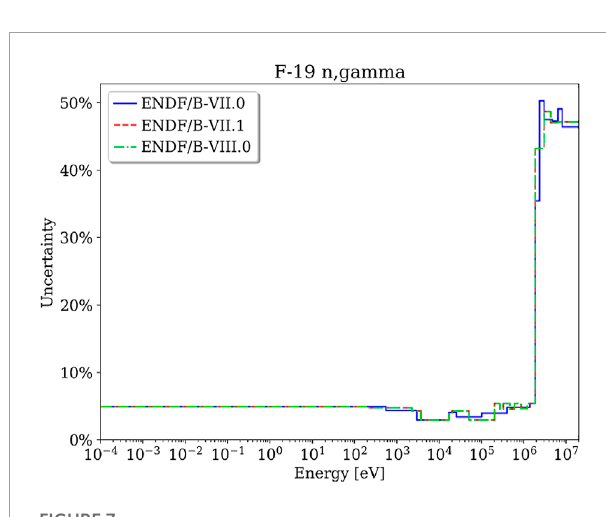
FIGURE 7 Relative uncertainty of the 19 F (n, γ ) cross section in different ENDF/B library